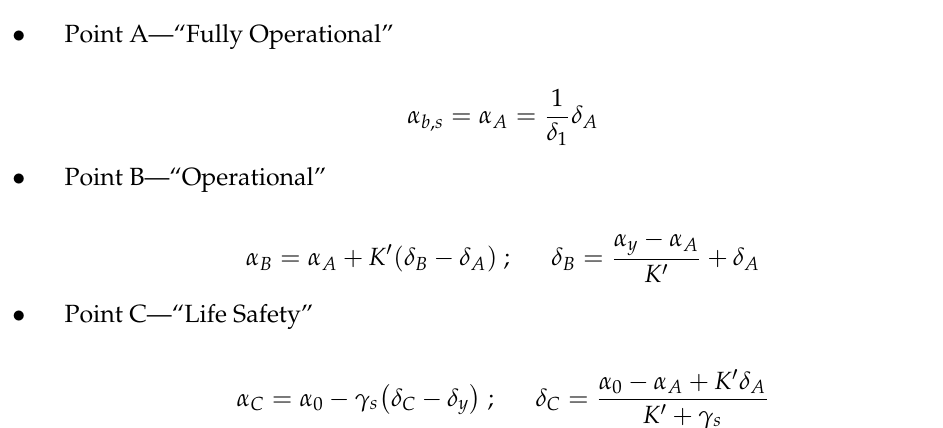
Figure 3. Characteristic performance points.